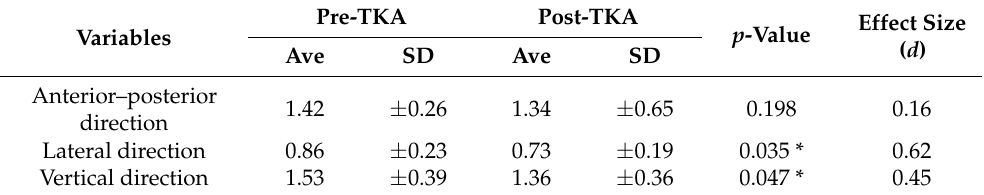
Table 3. RMS of COM during the walking stance